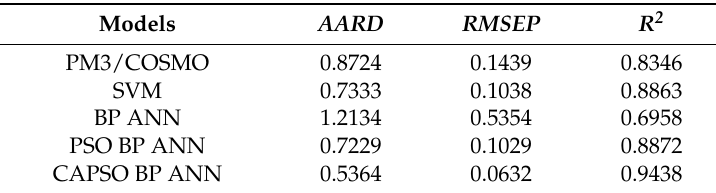
Table 5. Statistical results of each model. AARD : Absolute average relative deviation. RMSEP : Root mean square error of prediction. R 2 : Squared correlation coefficient.